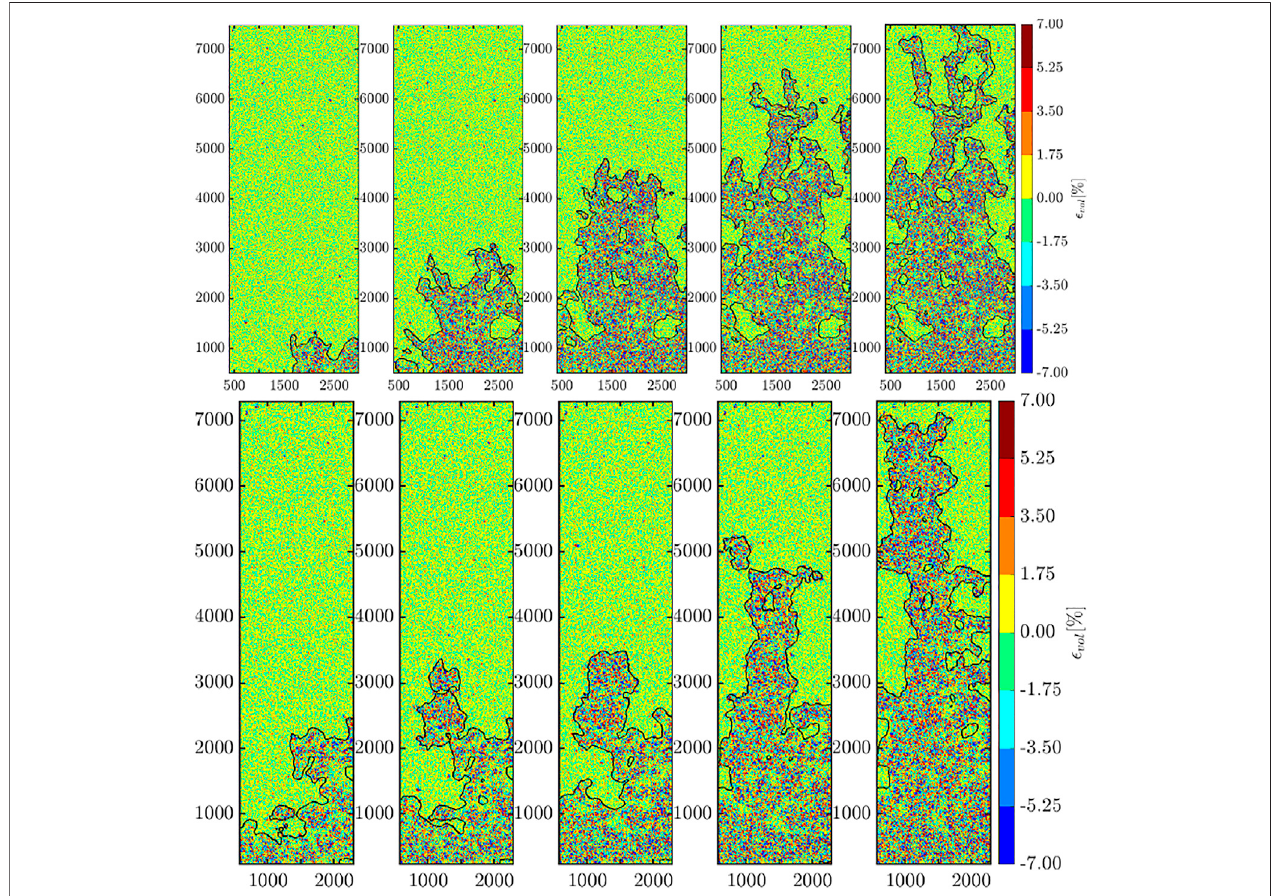
FIGURE6| Volumetricstrainmapsforameshsizeof fi vepixelsandaTikhonovregularizationof15pixelscorrespondingtoaseriesofimagescapturedduringtests (1) and (2). These time shots are marked by * in Figure 9 and Figure 10 .